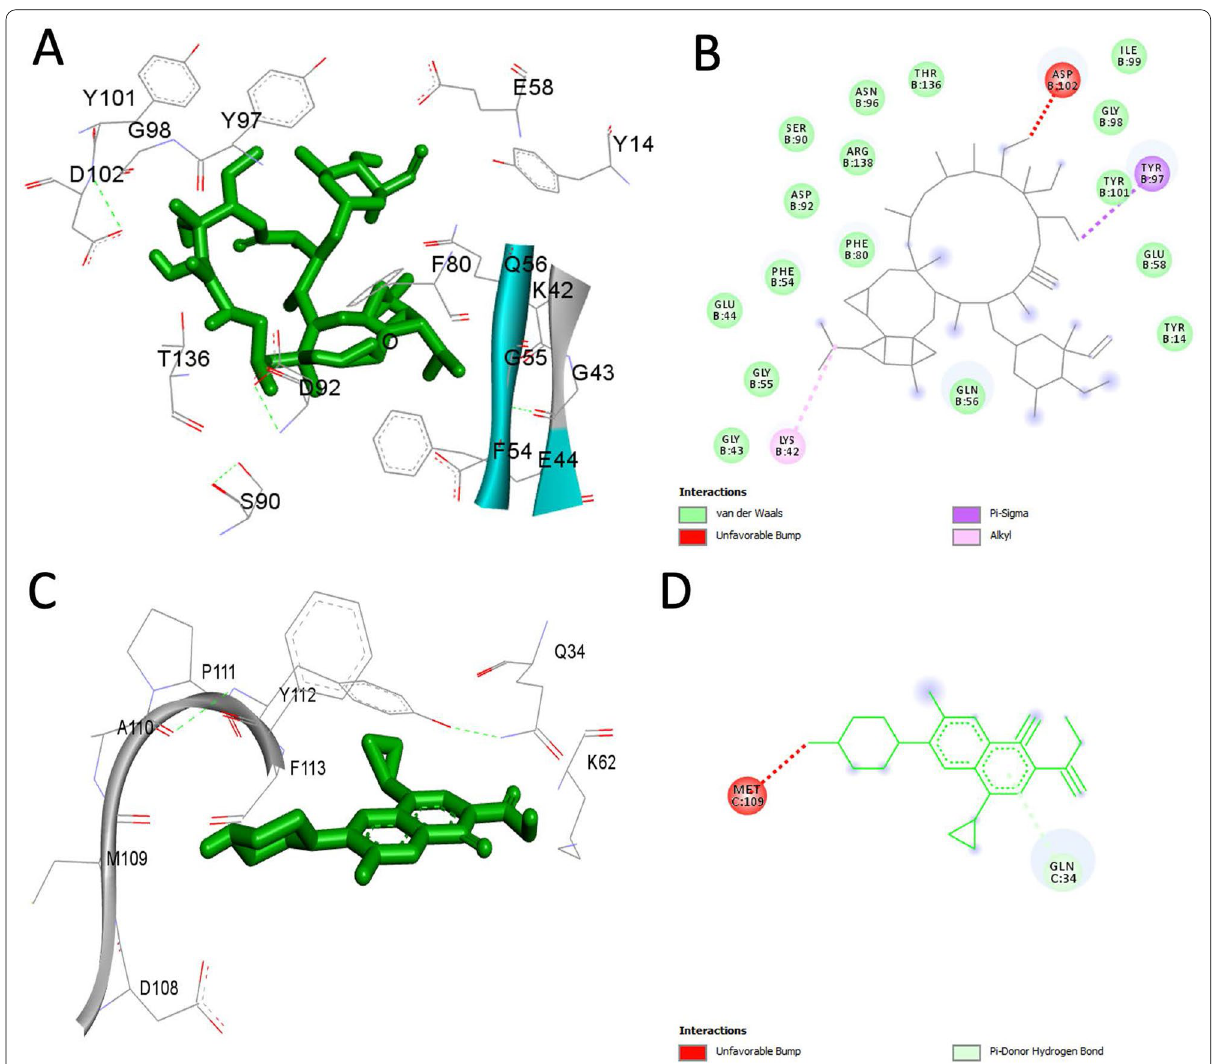
Fig. 2 Molecular interactions of commercially available drugs against S. typhi OmpF. Azithromycin 3D interaction ( a ) and 2D interaction ( b ); Ciprofloxacin 3D interaction ( c ) and 2D interaction ( d